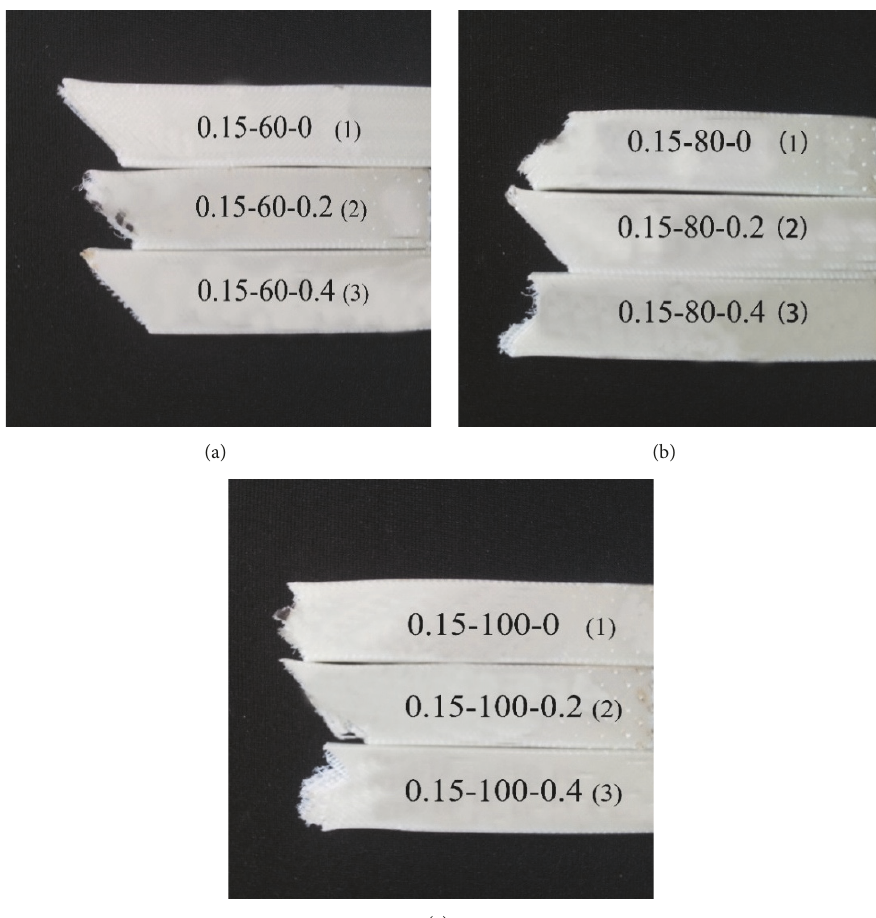
Figure 9: The failure specimen at different building levels of deposition velocity and air